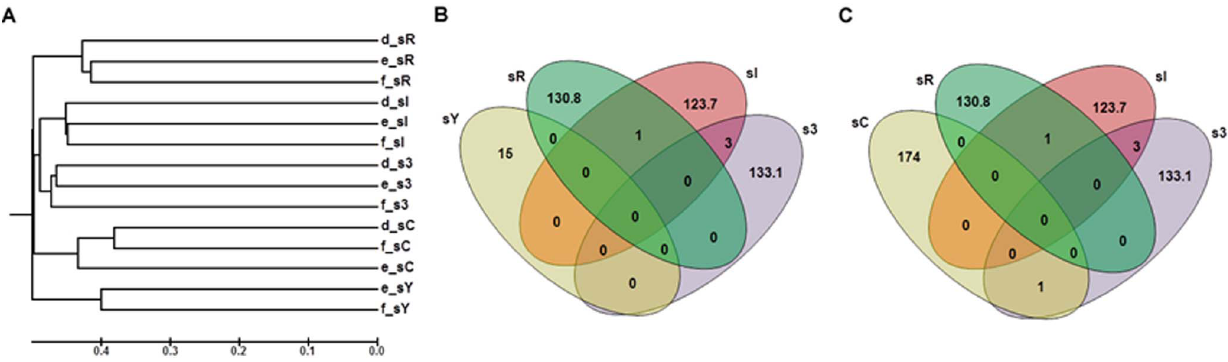
Figure 4. Dendrogram describing the dissimilarity (1-similarity) among the sampling sites (A). The groups were clustered using the UPGMA algorithm and the Jaccard similarity coefficient based on the observed richness. The clone libraries are denoted as follows: the letters (d), (e) and (f) correspond to the alkB -targeting primers described in Table 2, and the sampling sites (sI, sR, sY, s3 and sC) are described in the Materials and Methods. (B) and (C) Venn diagrams of all alkB phylotypes detected in each sampling site using a distance level of 97%